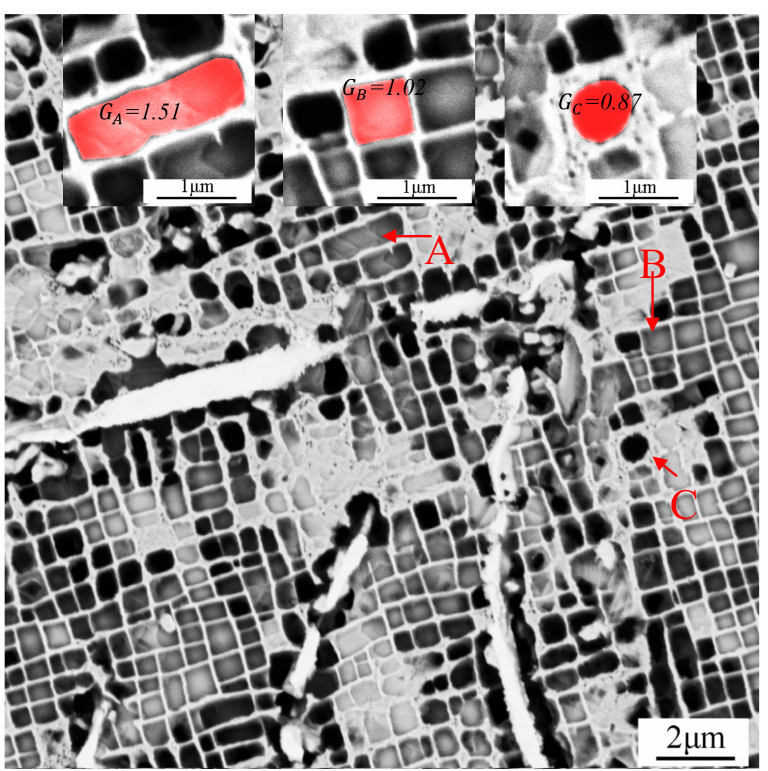
Figure 15. The γ ’ phases of typical geometric shapes and their geometric factors. G A , G B and G C are the geometric factors of the γ ’ phase corresponding to A, B, and C,